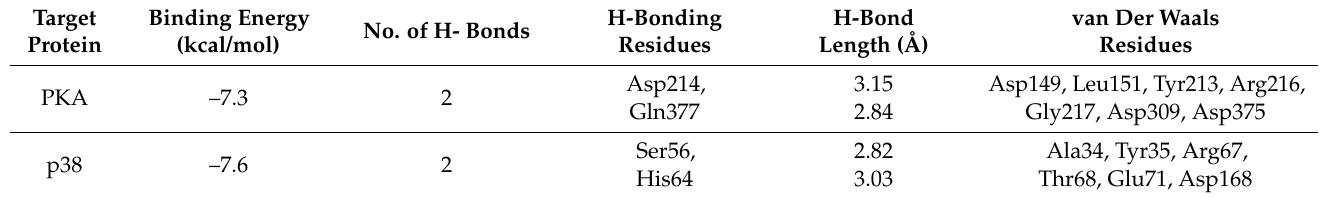
Table 1. Docking simulation of pinostrobin with upstream targets involved in